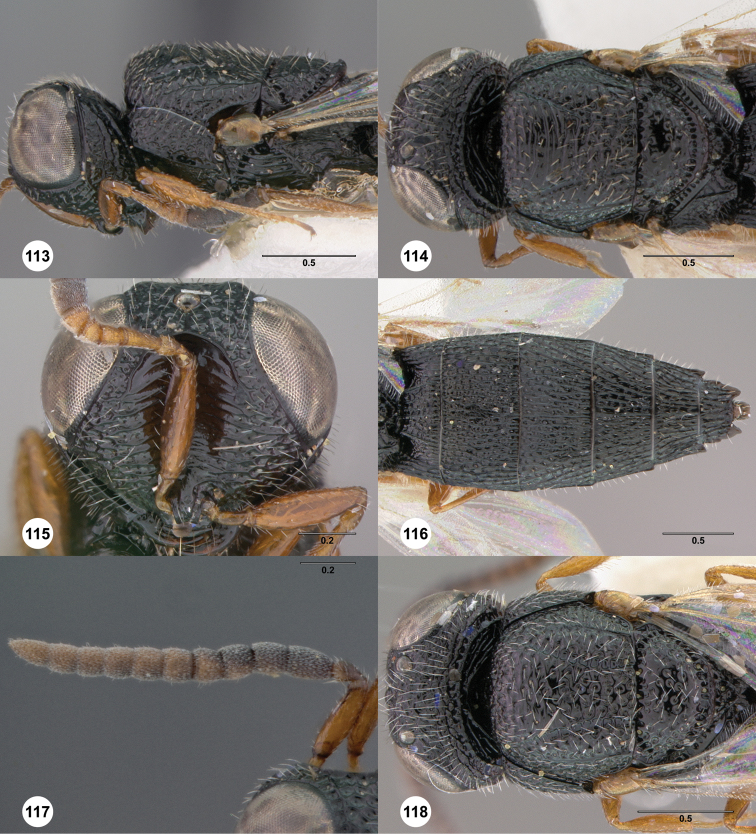
Oxyscelio foliorum sp. n., holotype female (OSUC 376702) 113 Head and mesosoma, lateral view 114 Head and mesosoma, dorsal view 115 Head, anterior view 116 Metasoma, dorsal view. Paratype male (OSUC 376701) 117 Antenna 118 Metasoma, dorsal view. Morphbank49